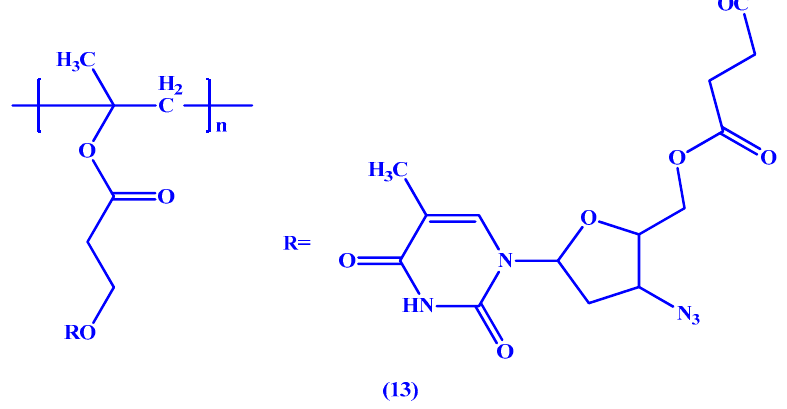
Figure 7. Chemical structure of the poly(HEMA)-AZT conjugate prodrug 13 .